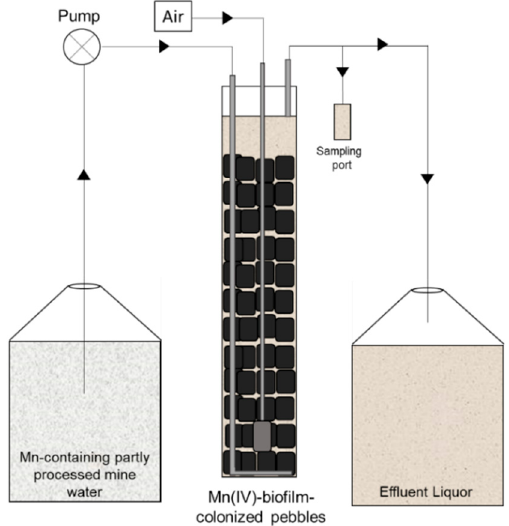
Figure 1. Schematic representation of the aerobic Mn (II)-oxidizing bioreactor. Mn-containing partly processed synthetic mine water was pumped into the bottom of the column, drained at the top and collected into an effluent bottle.